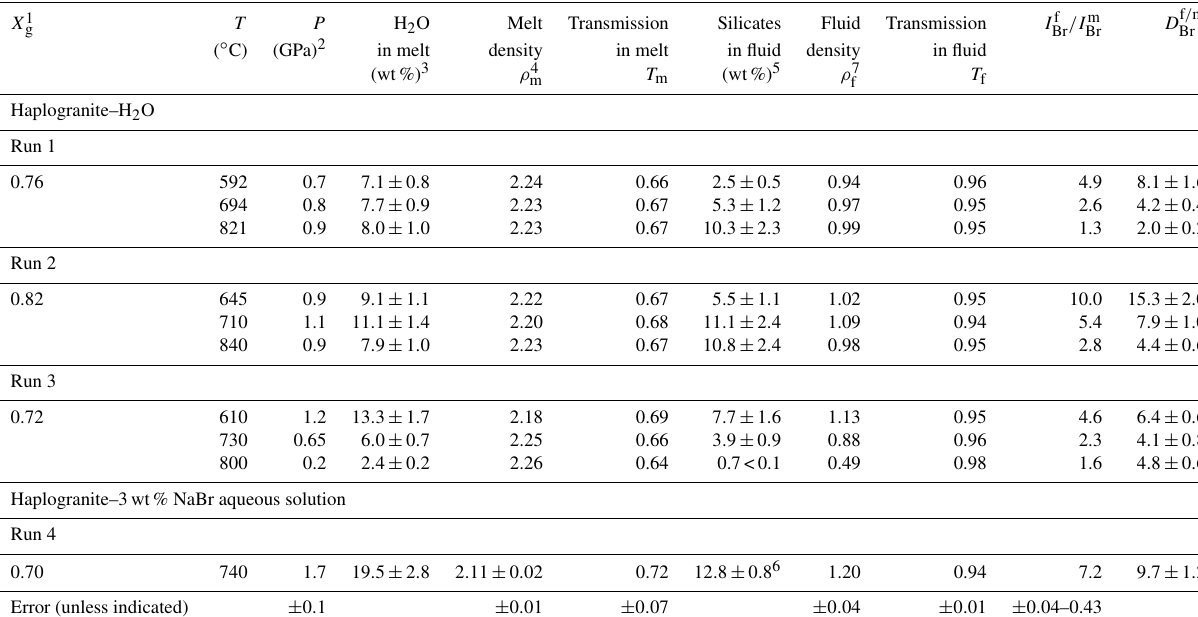
Table 2. Bromine fluid–melt partition coefficients at different P – T conditions. Calculated fluid and melt compositions as well as densities are also